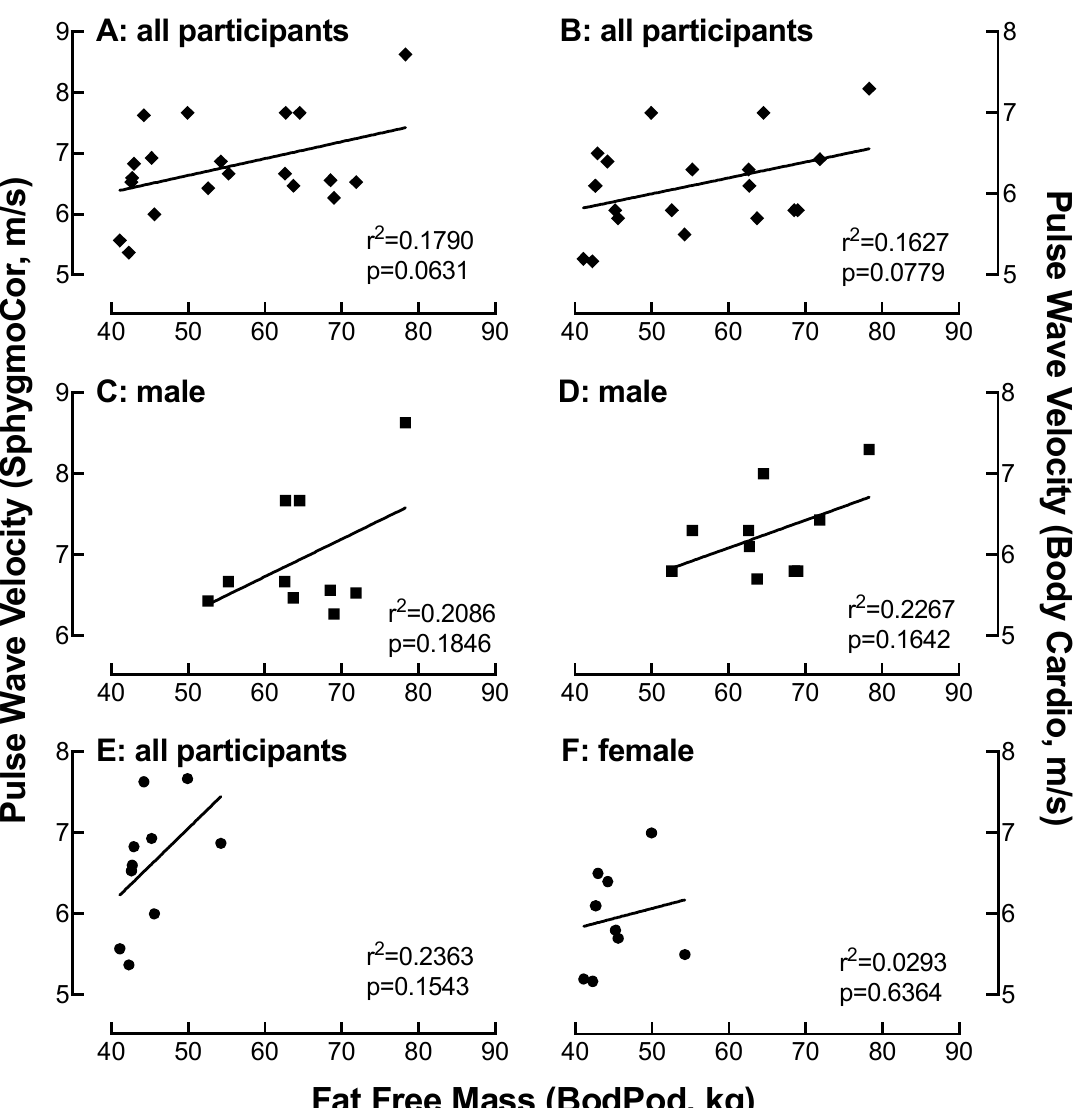
Figure 9. Relationship of FFM measured on the Bod Pod with PWV as a function of device. Comparison of FFM with PWV measured on the SphygmoCor ( A , C , E ) or the Body Cardio ( B , D , F ) in all participants ( diamond ) ( A , B ) or specifically in the male ( square ) ( C , D ) or female ( circle ) ( E , F ) population. Each data point represents duplicate or triplicate measures in one study participant.